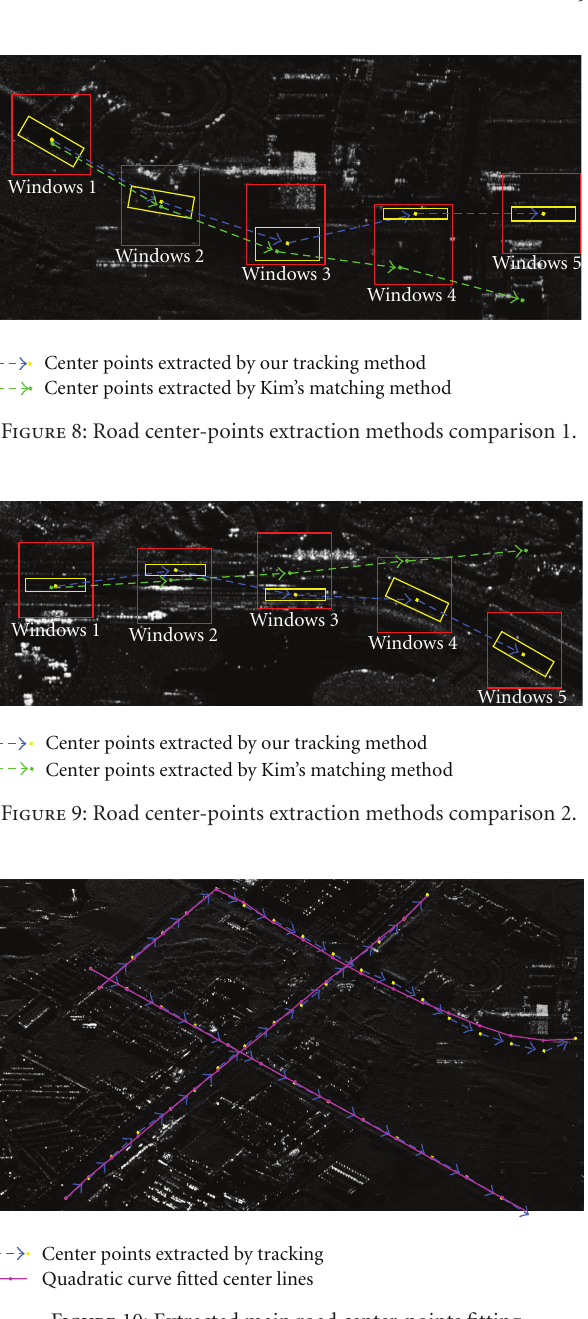
Figure 10: Extracted main road center-points